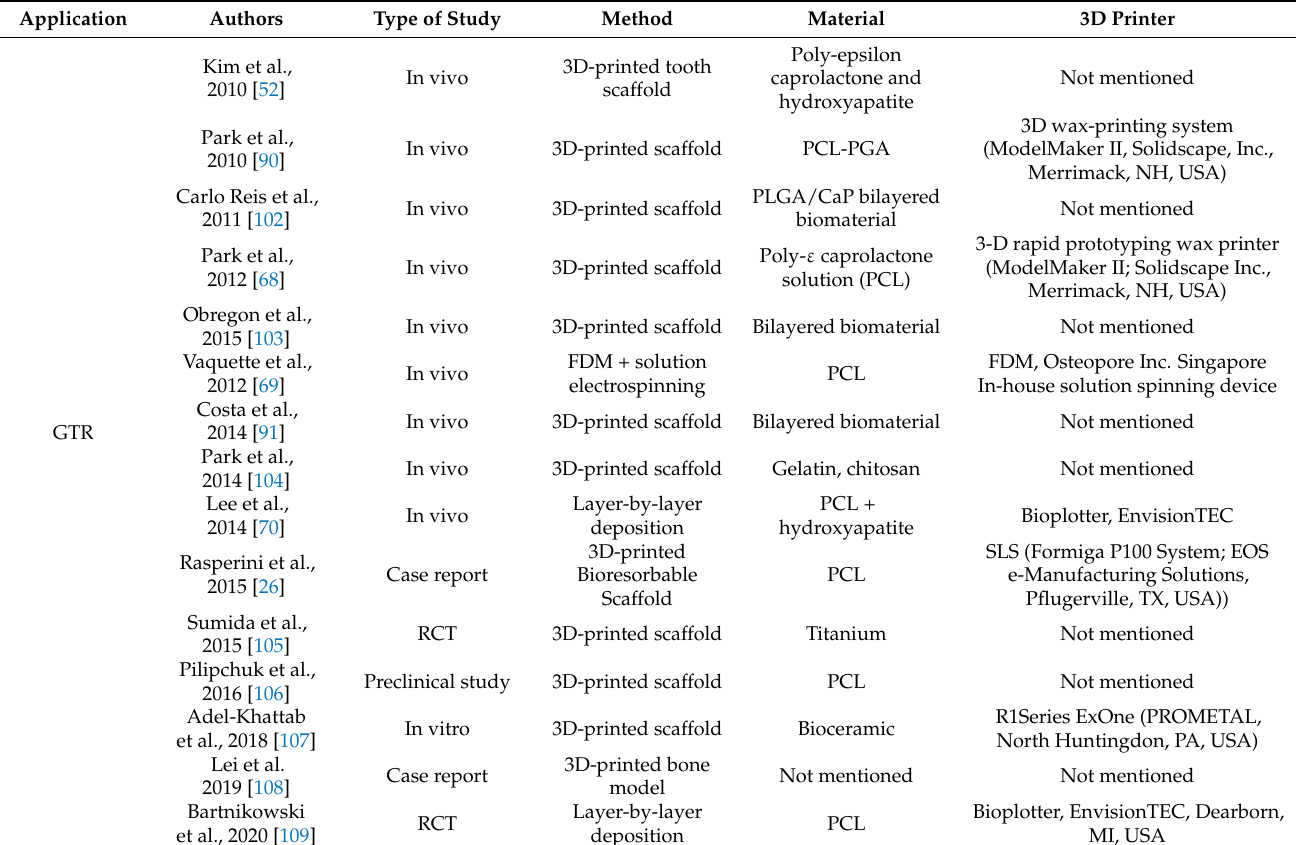
Table 2. Applications of 3D printing in